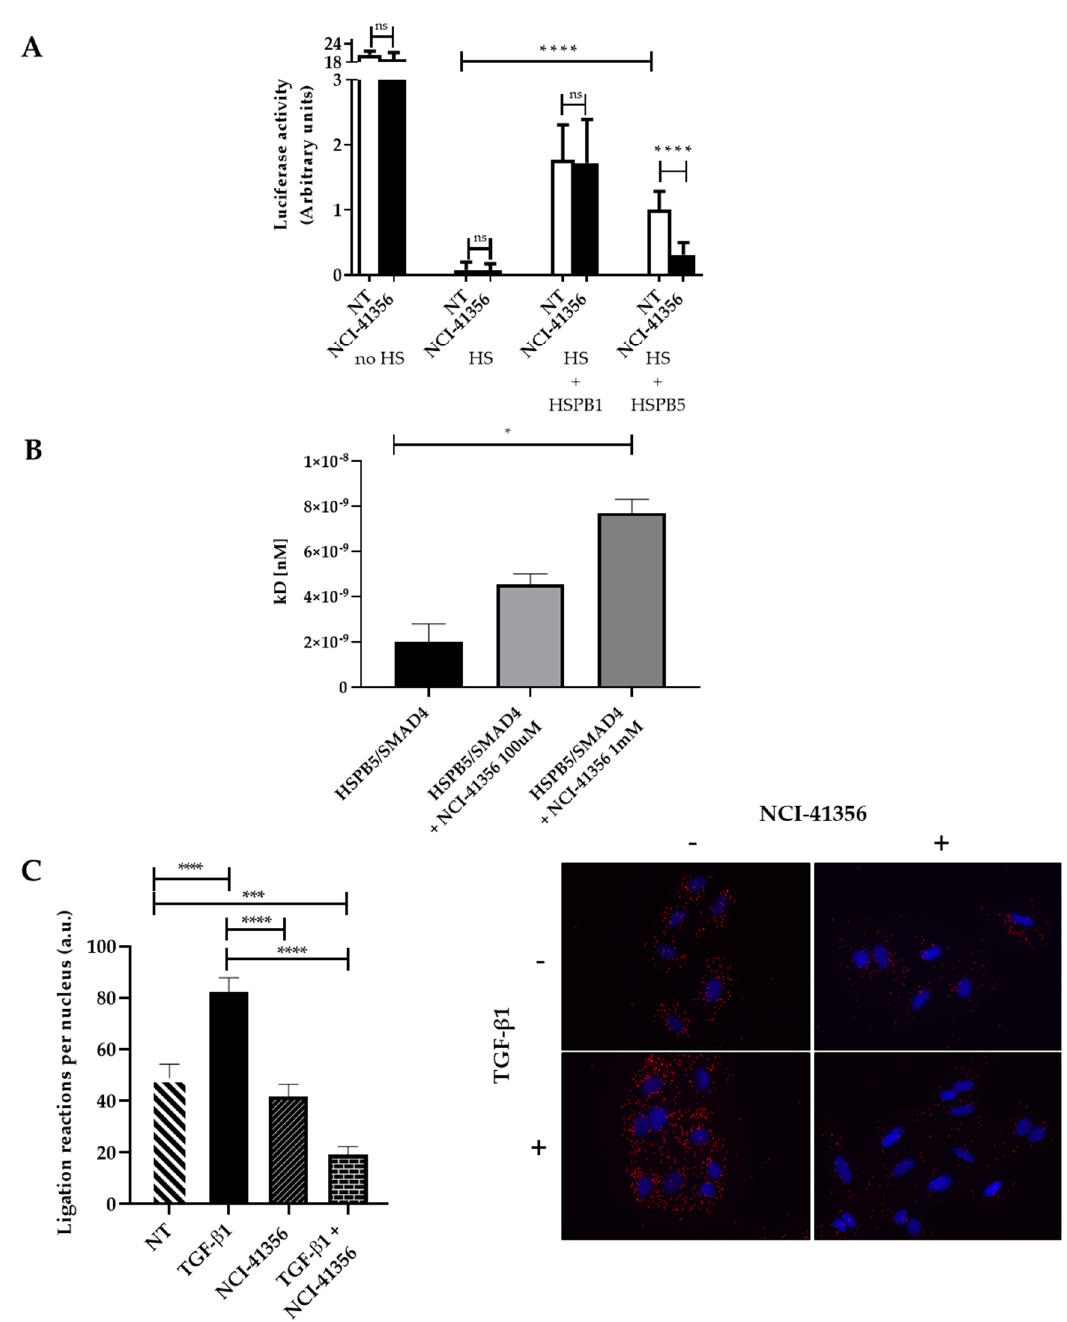
Figure 3. NCI-41356 decreases SMAD4/HSPB5 interaction. ( A ). Anti-aggregation assay on luciferase exposed to heat shock (HS) in presence or absence of recombinant chaperone HSPB1/HSPB5 (1.5 µ M) and NCI-41356 (100 µ M) ( n = 3) (**** p < 0.0001); ( B ). Interaction measurement by thermophoresis between HSPB5 and SMAD4 proteins in presence or not of NCI-41356, tested at 100 µ M and 1 mM (* p = 0.0107); K D (dissociation constant); ( C ). Proximity ligation assay between SMAD4/HSPB5 on A549 cells treated by either NCI-41356 (100 µM) or TGF- β 1 (10ng/mL) or both compounds (quantifica- tion one the left and representative image on the right) (×40); One red spot matches with one interaction between these two proteins ( n = 3) (*** p = 0.0003; **** p < 0.0001). Data are expressed as means ± SEM and compared using nonparametric Mann–Whitney (anti-aggregation assay) and Kruskal–Wallis tests (thermophoresis assay) or one-way ANOVA (PLA as- say).